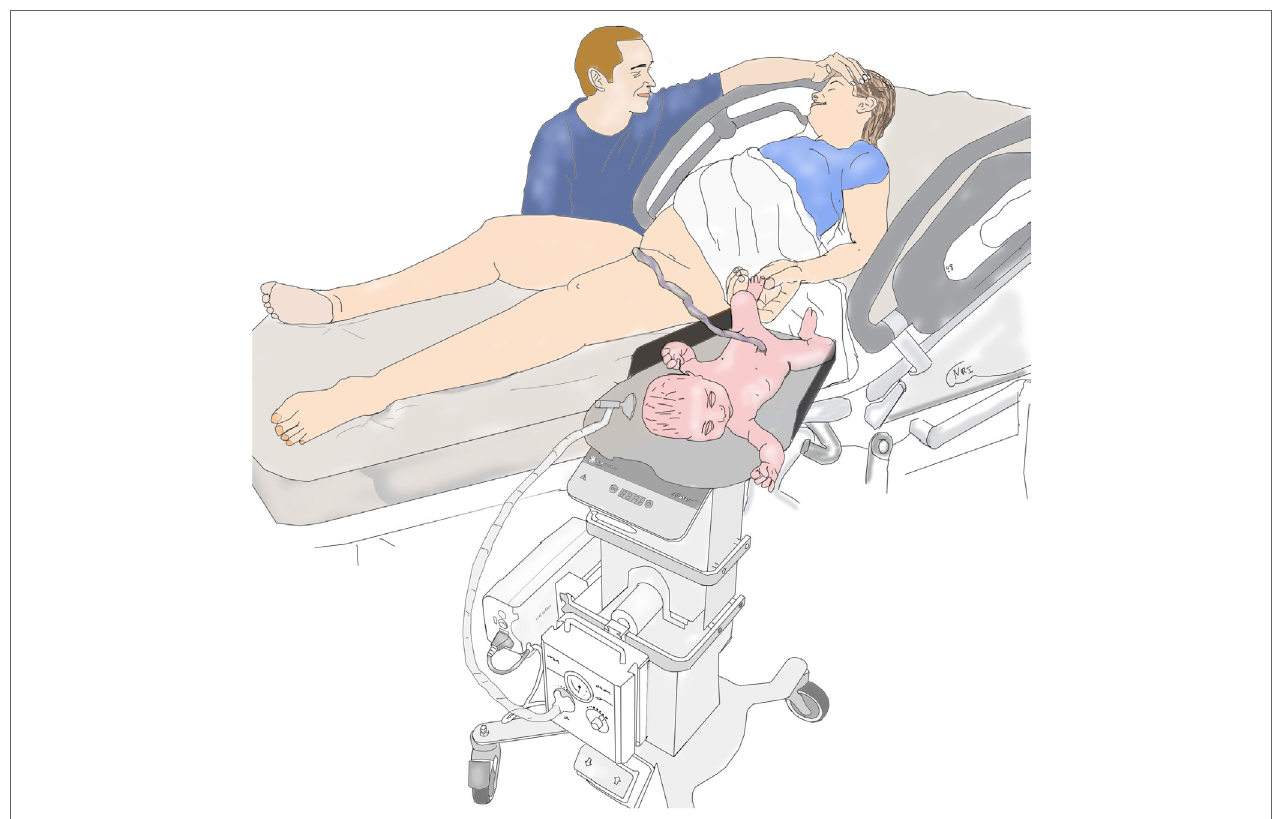
FigUre 2 | Setup for vaginal delivery in the United